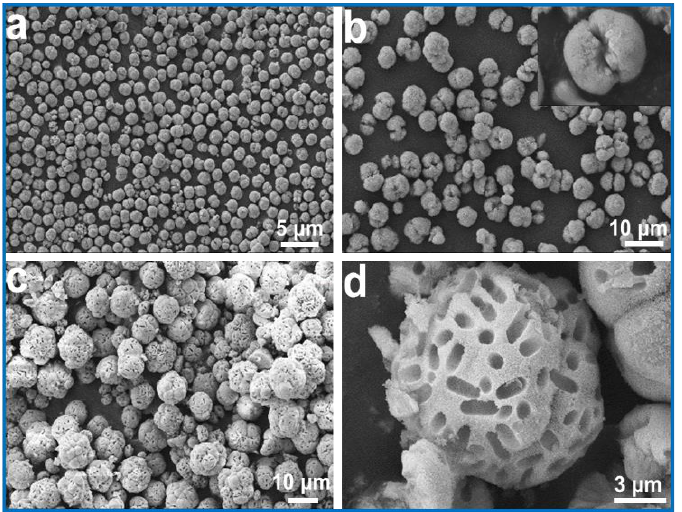
Figure 1. Typical SEM images of SrCO 3 nanocrystals obtained in the absence of nano-montmorillonite (nano-MMT) when the mineralization time were 6 h ( a ), 12 h ( b ), 18 h ( c , d ),